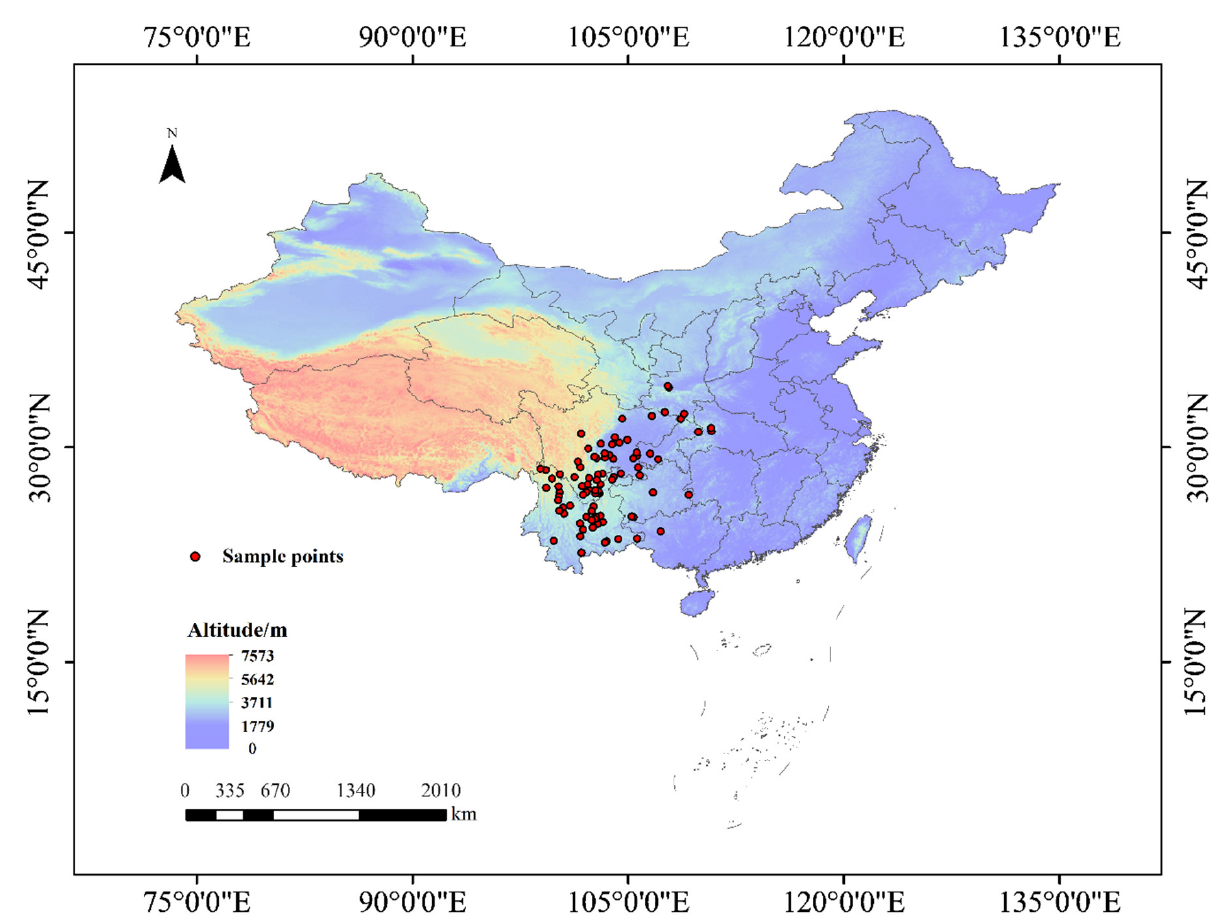
Figure 1. Geographical distribution of S. delavayi in China.